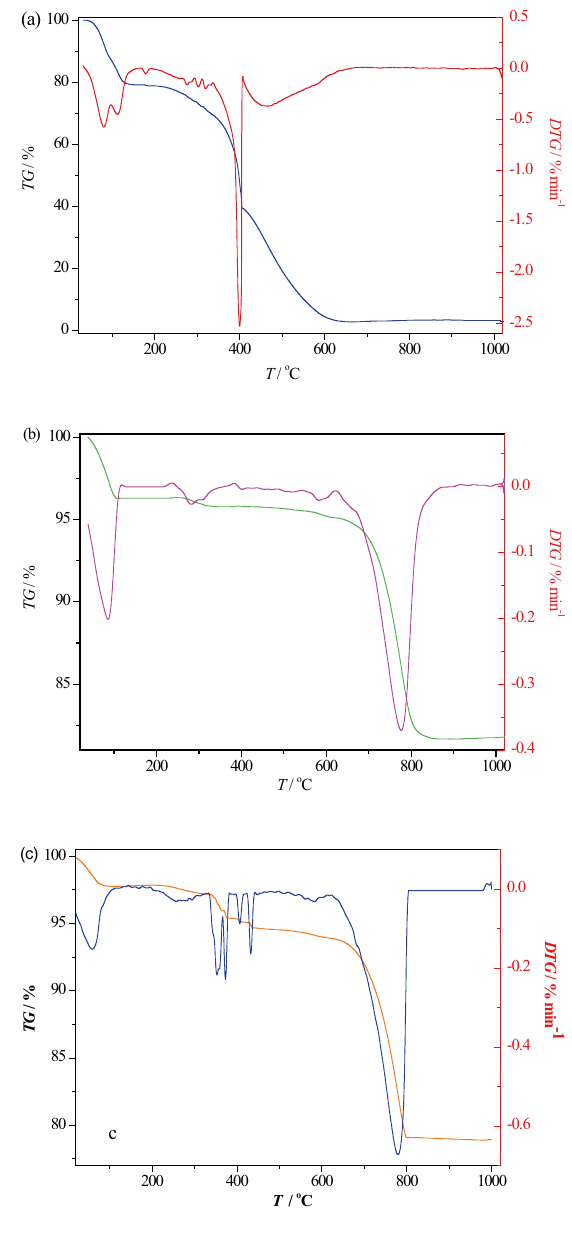
Figure 4. TG/DTG curves of methylene blue ( a ), NiO/sepiolite ( b ) and NiO/sepiolite adsorbed with methylene blue ( c ) under 20 cm 3 /min of O 2 (heating rate = 10